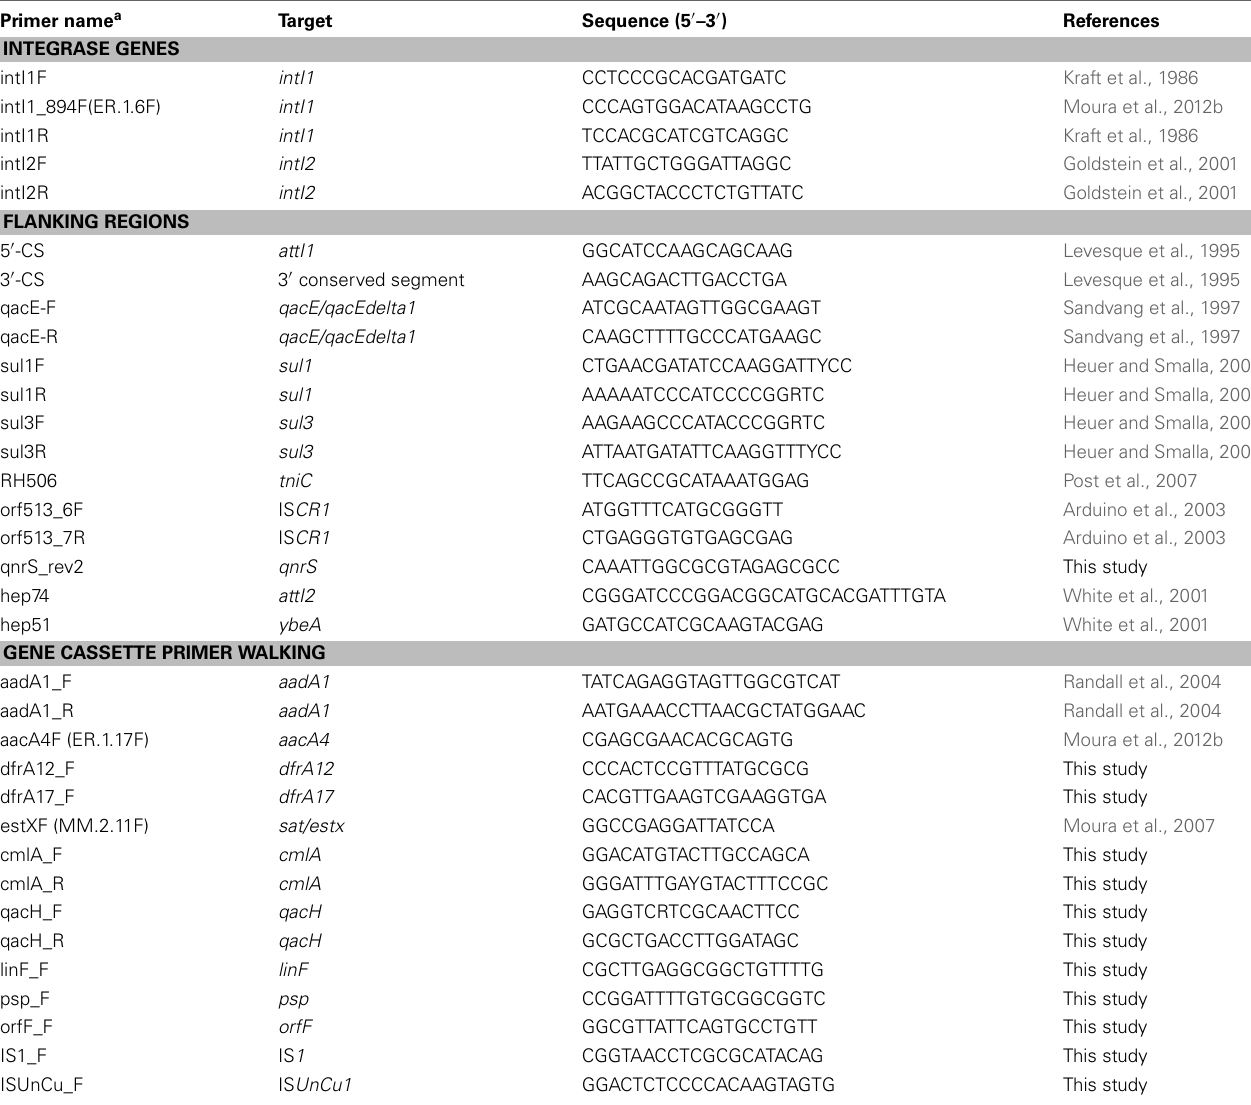
Table 1 | Primers used in this study in the characterization of